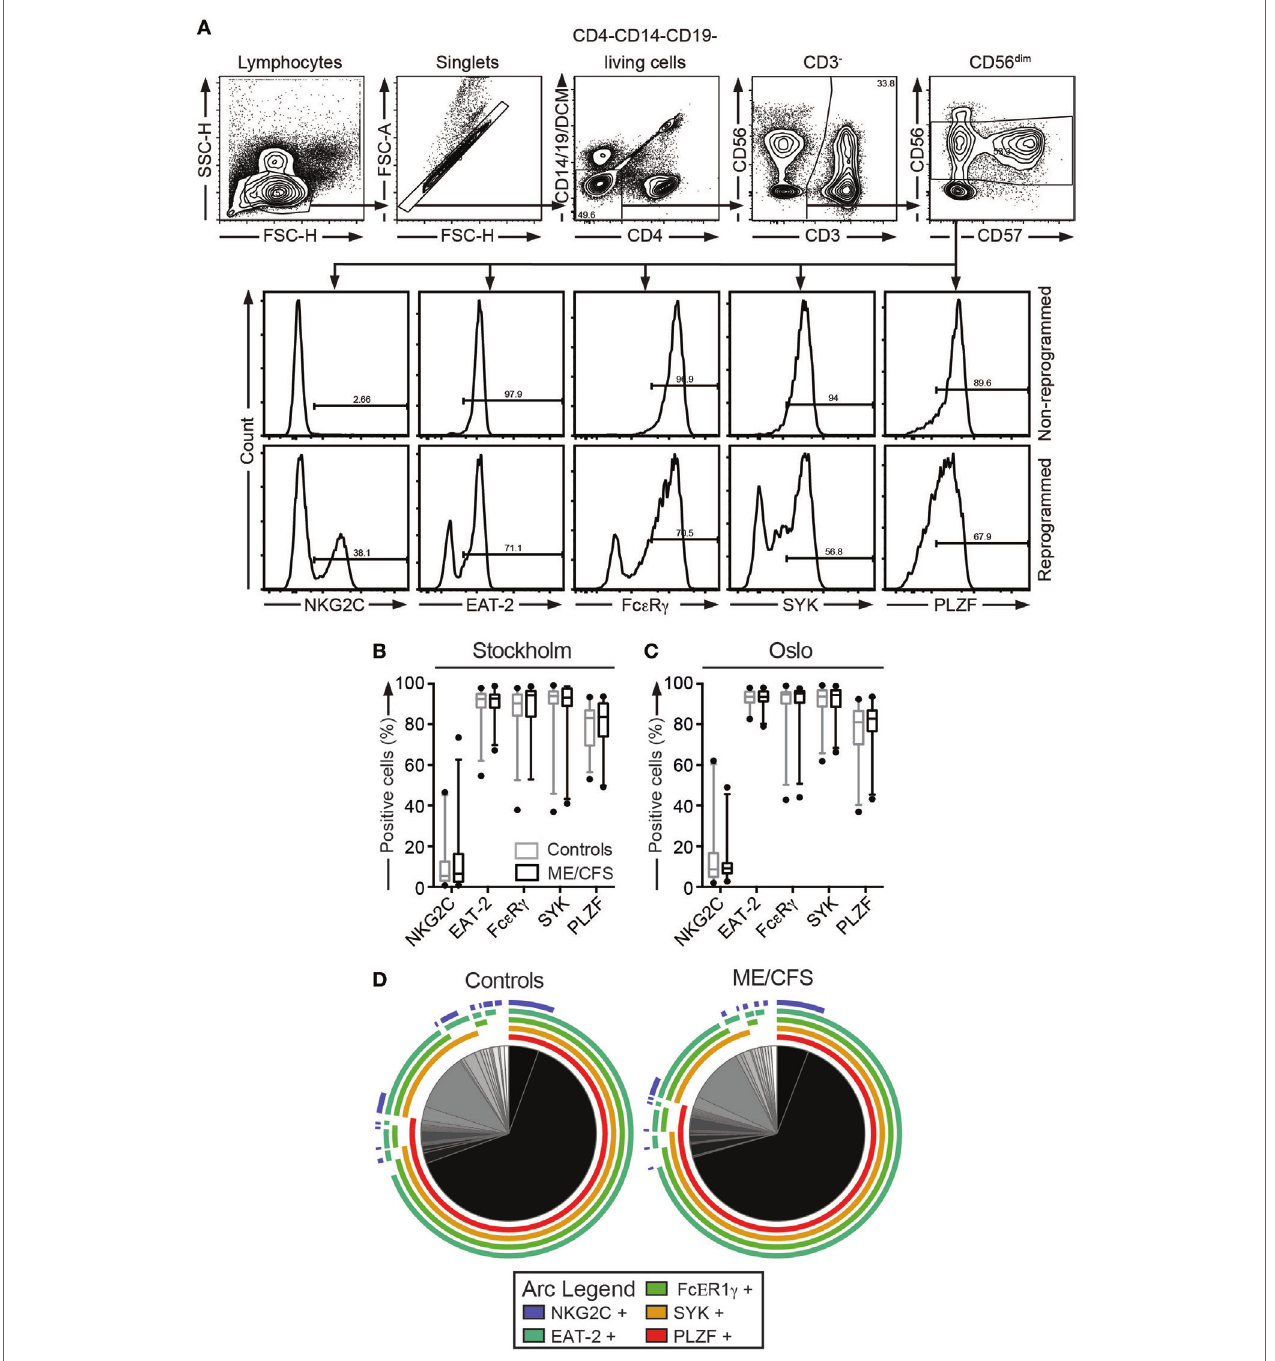
FigUre 4 | Investigation of expanded adaptive natural killer (NK) cell subsets does not reveal any differences between ME/CFS patients and controls. (a–D) Analysis of percentages of adaptive NK cell expansions. Peripheral blood mononuclear cells were thawed and stained with antibodies to lineage markers, NKG2C, and a dead cell marker, fixed, permeabilized, and stained intracellularly for Fc ε R γ , SYK, EAT-2, and PLZF. (a) Gating strategy for one representative donor is shown. Histograms depict one donor without and one donor with adaptive NK cell expansions. (b,c) Percentage of CD3 − CD56 dim NK cells positive for NKG2C, Fc ε R γ , SYK, EAT-2, and PLZF in the Stockholm and Oslo substudies, respectively. Adaptive NK cells express combinations of high NKG2C and low Fc ε R γ , SYK, EAT-2, and PLZF. Gray boxes depict control values, whereas black boxes depict patient values. Lines through boxes show the median. Error bars extend to 5th and 95th percentile. Dots show outliers. (D) Pie charts of Boolean analyses of subsets expressing any combination of NKG2C, Fc ε R γ , SYK, EAT-2, and PLZF. If an arc is drawn over a specific pie slice, then the connected marker is present on the pie slice in question. Following this, the majority of cells are positive for Fc ε R γ , SYK, EAT-2, and PLZF, and thus non-adaptive. 24 patients and 28 controls and 24 patients and 24 controls for the Stockholm and Oslo substudies, respectively, are included in the